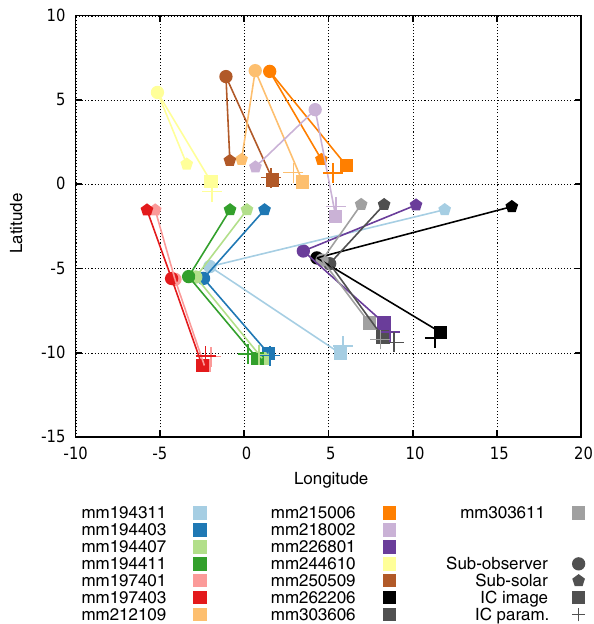
Figure 8. Illustration of the IC parameterisation. For each ROLO reference image, the sub-observer point P sobs , the sub-solar point P ssol and the IC location in the ROLO images P icen are plotted onto a grid of lunar coordinates. The parameterised IC (shown as a cross) is in all cases close to the observed intensity